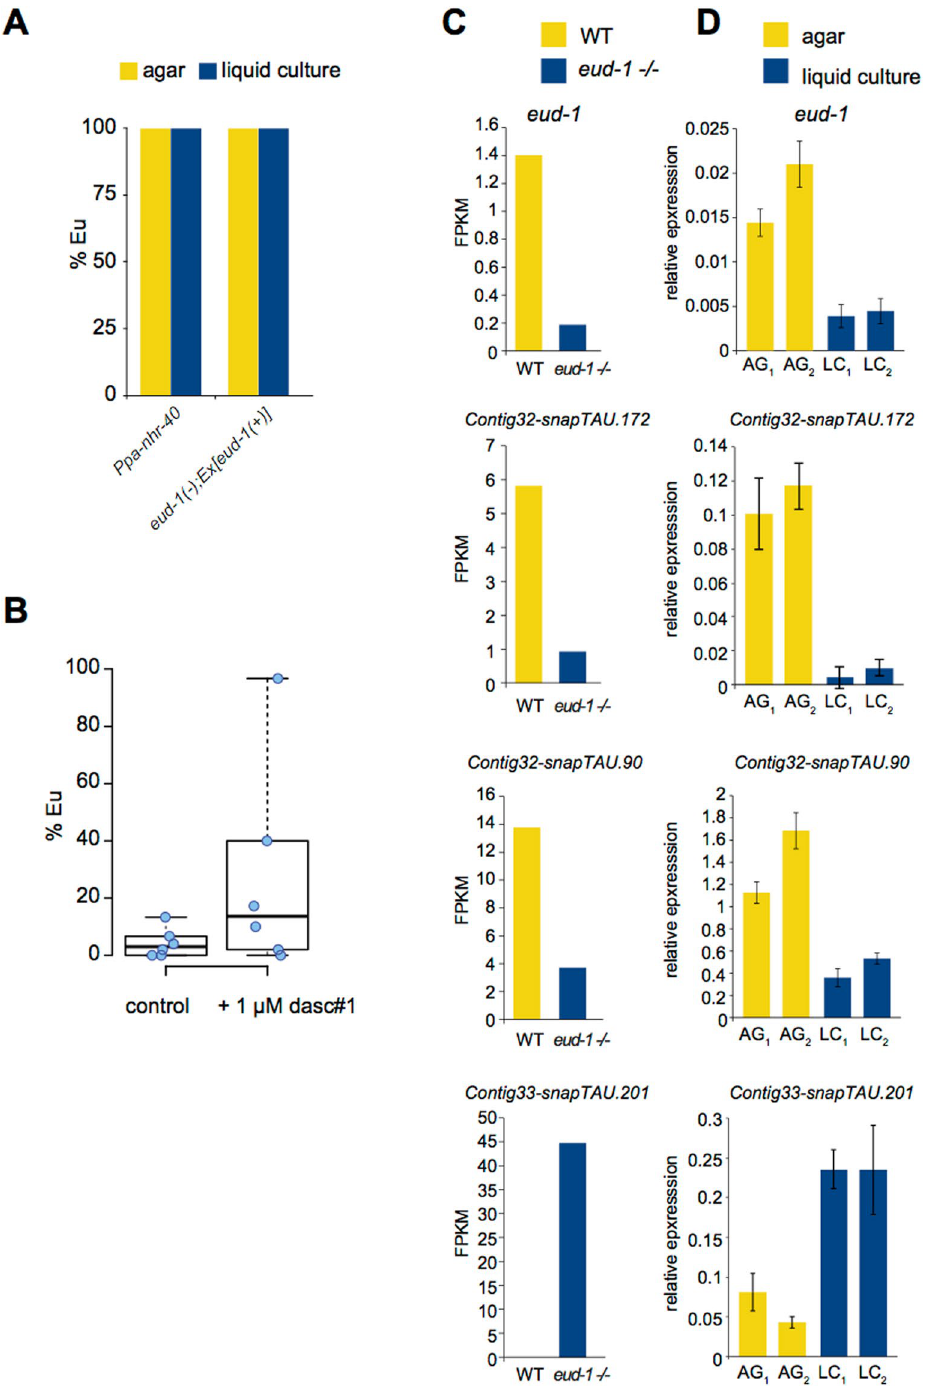
Figure 4. The environmental effect of liquid culture is upstream of known genetic components and induces similar pathways. ( A ) Mouth-form ratios of eud-1 overexpression 27 and a Ppa-nhr-40 28 mutant in liquid culture reveals no effects, suggesting these genes are downstream, n = 3 biological replicates. ( B ) Addition of 1 µ M dasc#1 exhibits a variable response that appears to induce Eu, although it is not statistically significant ( p = 0.068). ( C ) Expression analysis of four genes by RNA-seq from eud-1 mutants (the average of 4 homozygous mutant alleles is represented) 27 (100% St) compared to the RS2333 California strain (70–100% Eu), y-axis = fpkm (relative expression). ( D ) Reverse transcription-quantitative PCR (RT-qPCR) of P . pacificus PS312 grown in liquid culture/S-medium (LC) vs. NGM-agar plates (AG) for the two biological replicates displayed, with four technical replicates each. The y-axis represents 2 Δ Ct (relative expression) compared to the housekeeping gene Ppa-Y45F10D . 4 (iron binding protein) 69 , error bars represent standard deviation of n = 4 technical